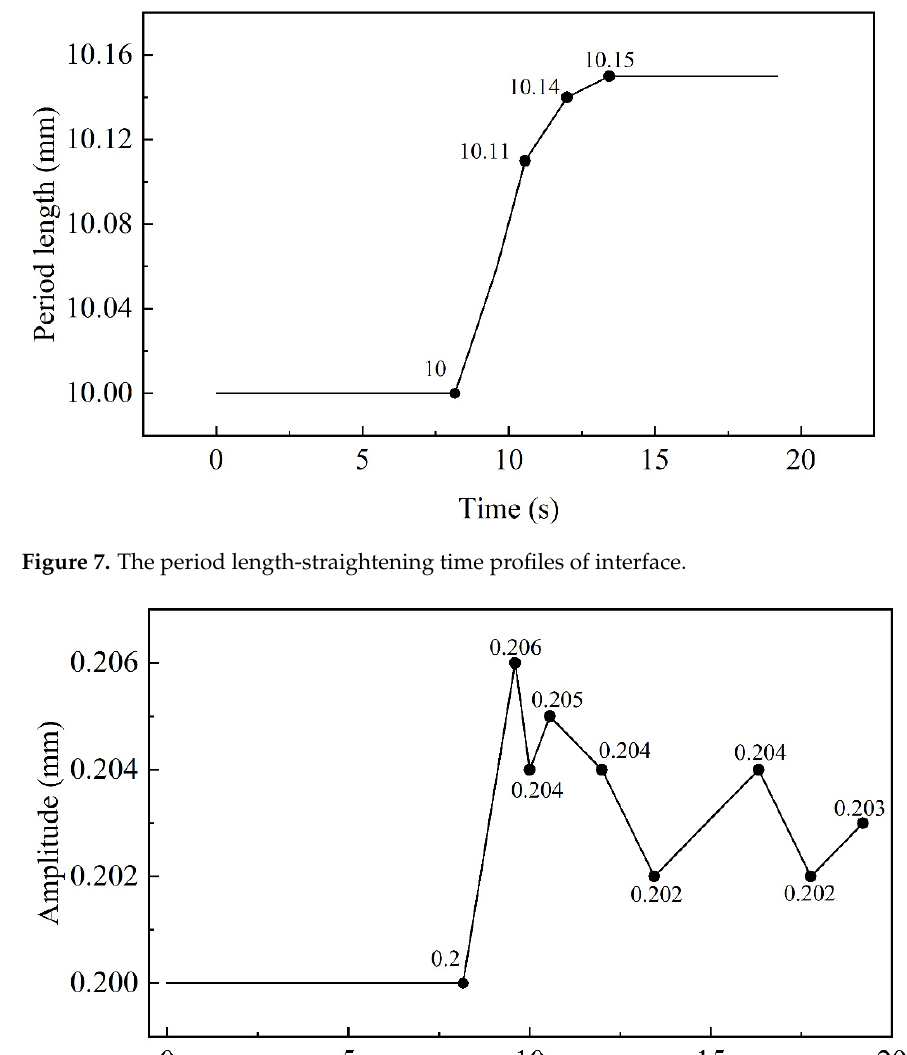
Figure 6. Grid division.